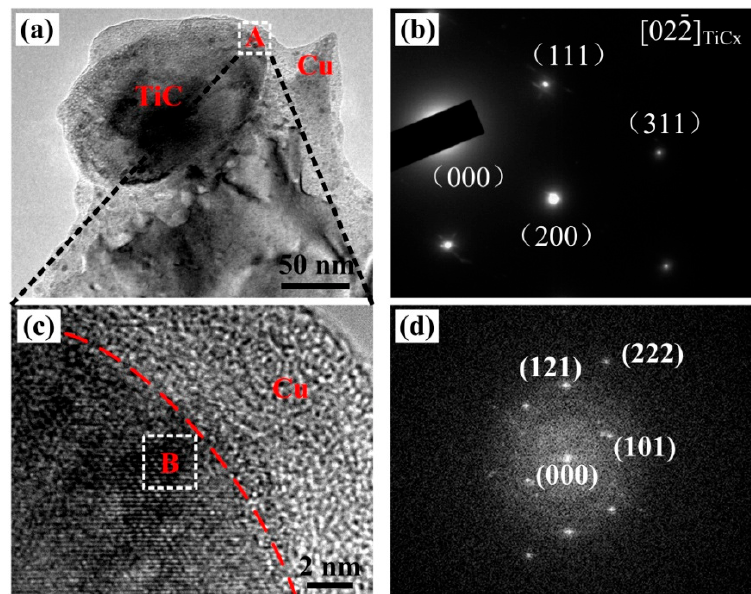
Figure 9. ( a ) TEM images of 4 wt % nano-sized TiCp-reinforced Cu–Cr–Zr composites, ( b ) the images of TiC p electron diffraction pattern, ( c ) the HRTEM image corresponding to area A, and ( d ) the FFT images corresponding to area B.